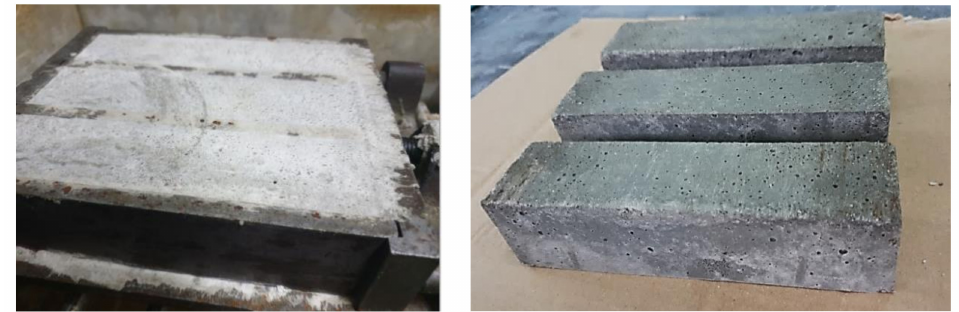
Figure 9. The view of mortars incorporating 30% of slag from MSWI in form and samples were taken from after 1 day with 40 × 40 × 160 mm (authors’ photo). No change of the mortar volume was